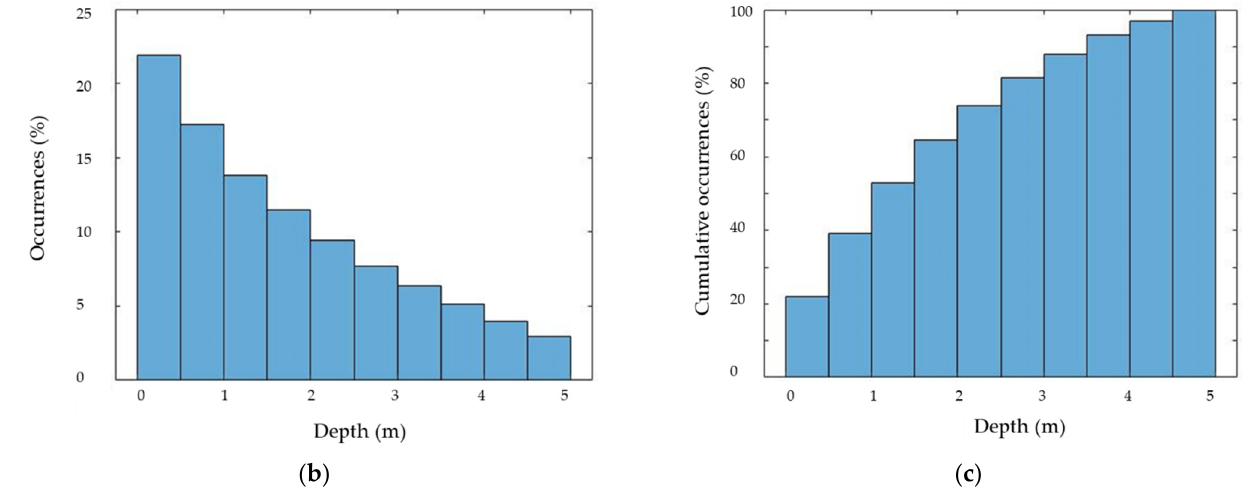
Figure 12. ( a ) Spatial distribution of FC (color bar in %) retrieved by the neural network approach for the OLCI scene acquired on 8 July 2017; ( b ) histogram of the Sargassum occurrence (in %) and ( c ) cumulative histogram of the Sargassum occurrence (in %) of depth retrieved by the neural network.